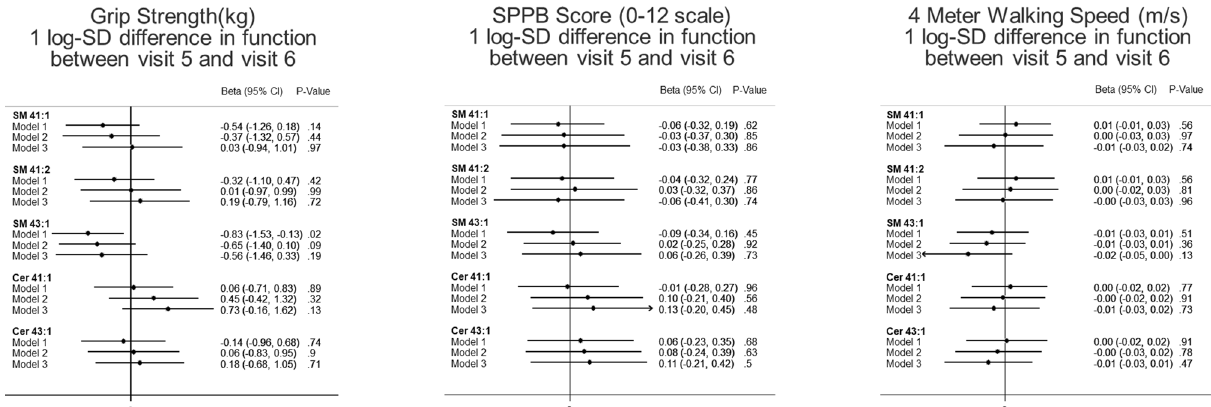
Figure 3. Longitudinal weighted associations of sphingomyelins and ceramides with change in physical function between ARIC visit 5 and 6. Multiple linear regression model was used to determine β-coefficients [95% confidence internal] between each metabolite (log-transformed concentration modeled in z score) and changes in physical function. Model 1 covariates: age, sex, race-site, and batch effects. Model 2 covariates: model 1, plus body mass index, diabetes status, hypertension status, use of lipid lowering medication, total cholesterol, Digit Symbol Substitution test z-score, and prevalent stroke at the ARIC visit 5. Model 3 covariates: model 2, plus education, presence of an APOE4 allele, Mini-mental state examination (MMSE) score, sports index, previous heart failure, previous coronary heart disease, CES depression score, HDL cholesterol, triglyceride levels, SF bodily pain score, current smoking status, and current drinking